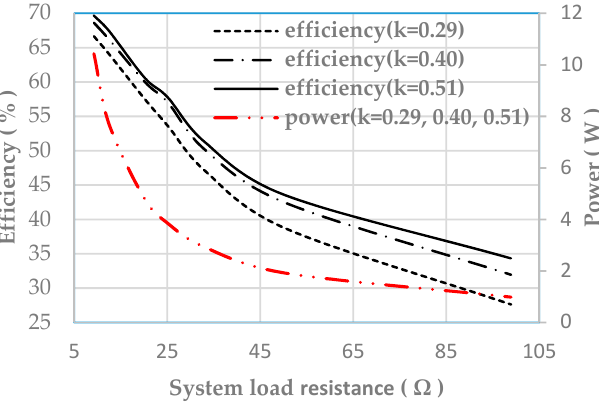
Figure 13. Comparison of efficiencies and power at different loads while k = 0.29, 0.40,